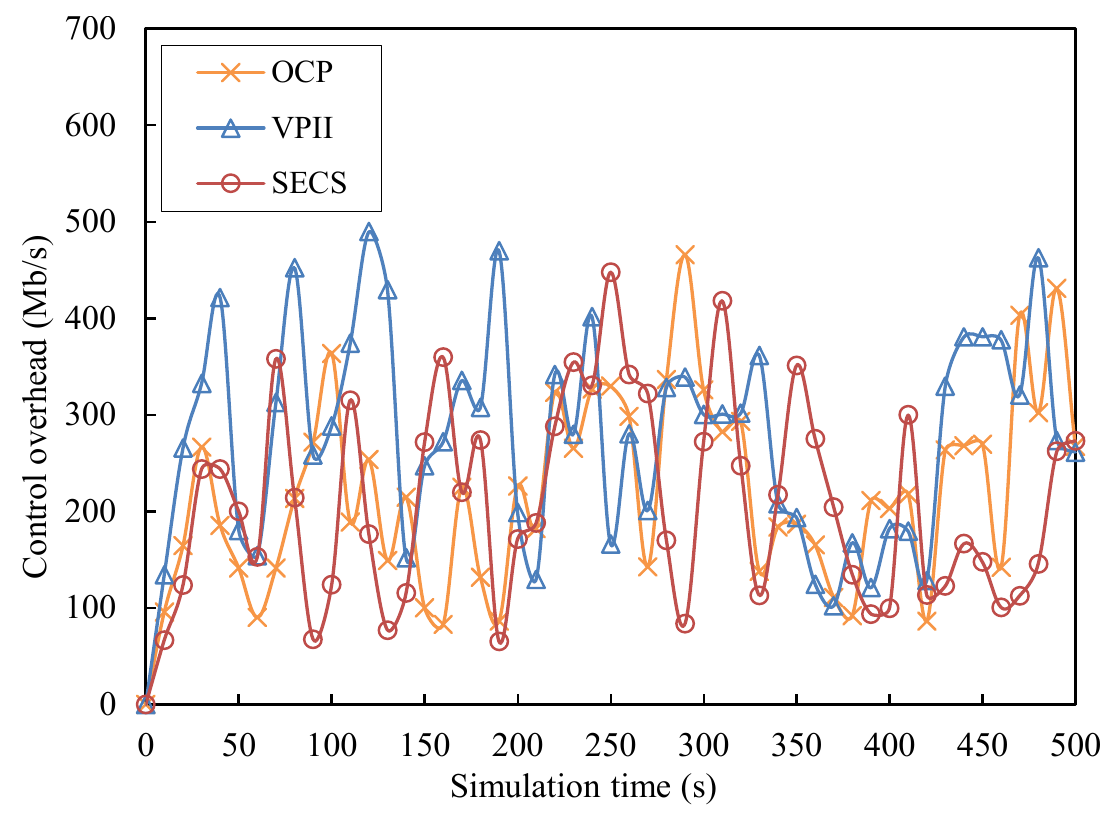
Figure 9. Control overhead against simulation